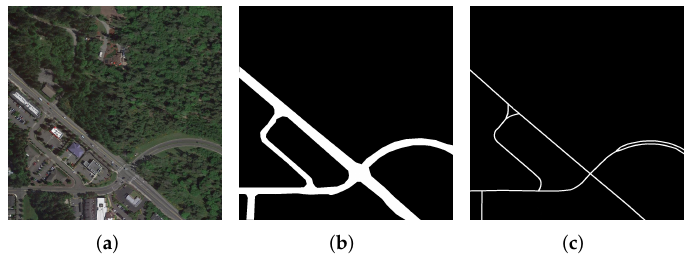
Figure 1. Sample images. ( a ) is the satellite image, ( b ) is pixel-wise annotation and ( c ) is OSM centerline which can be regarded as a sparse